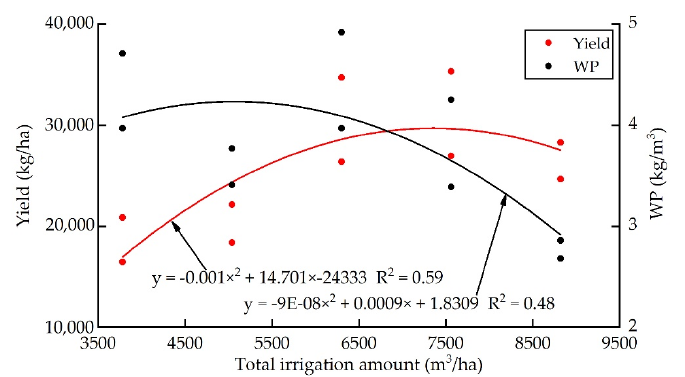
Figure 8. Relationships between total irrigation amount and apple yield and water productivity (WP) in 2019 and 2020. in 2019 and